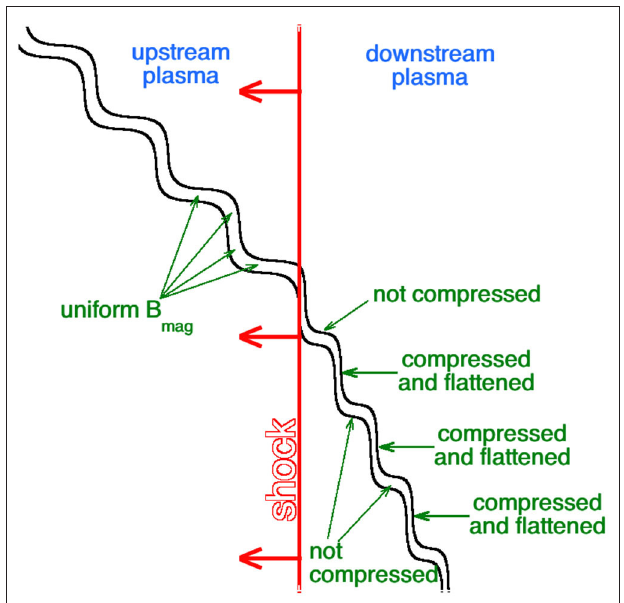
FIGURE 1 | The shocking of one flux tube in the spaghetti structure of the heliosphere is sketched, with the variable shock normal angle resulting in different amounts of magnetic compression.